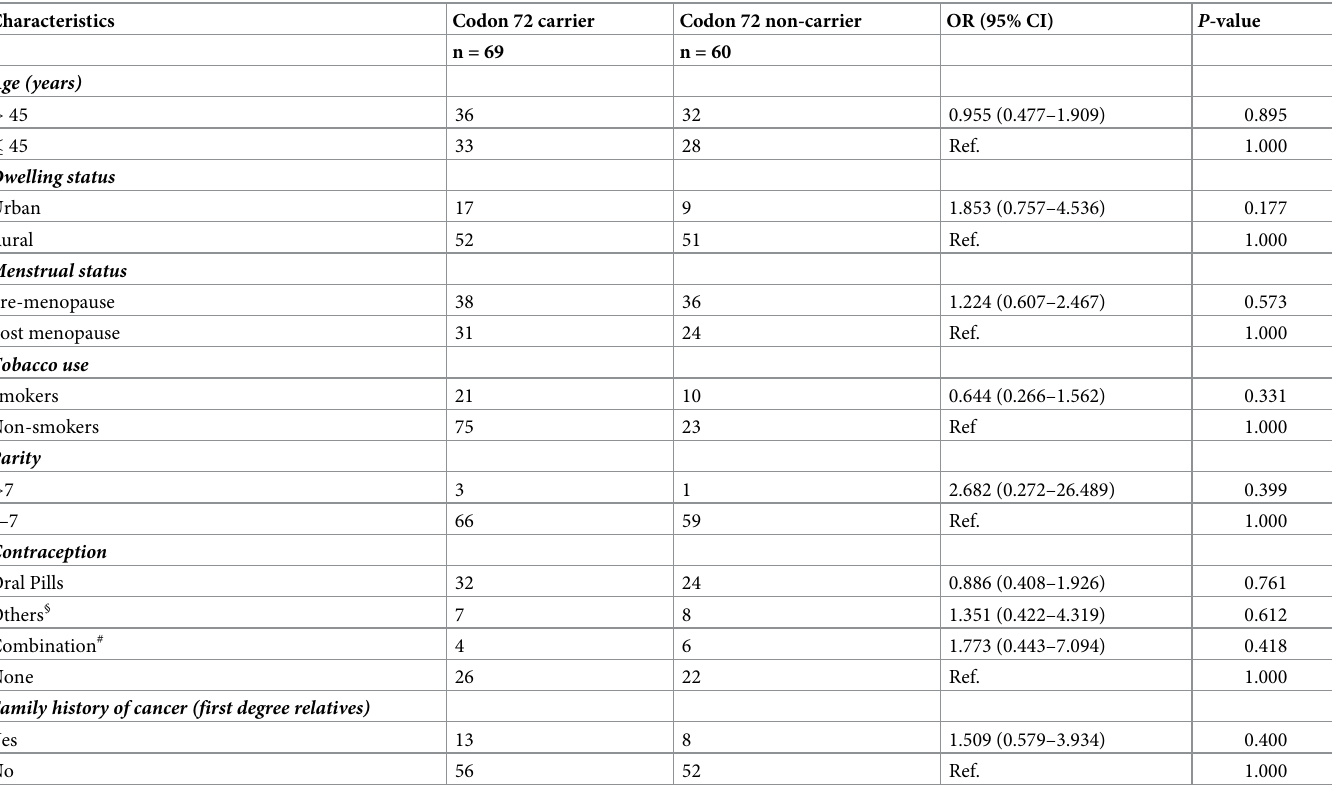
Table 4. Correlation of TP53 codon 72 polymorphisms with clinicopathological characteristics of the